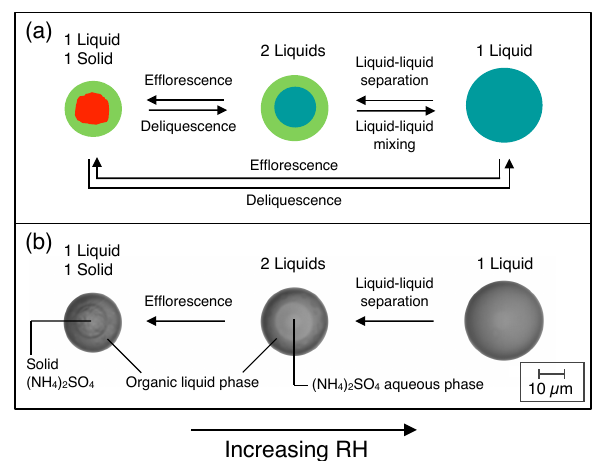
Fig. 1. (a) Some possible phase transitions of mixed organic- ammonium sulfate particles. These transitions can occur as atmo- spheric relative humidity fluctuates between high and low values. Aqua, green, and red respectively represent an aqueous phase, a liq- uid phase of organic material, and a solid phase of crystalline am- monium sulfate ((NH 4 ) 2 SO 4 ). (b) Optical microscope images of a single particle consisting of 1,2,6-trihydroxyhexane and ammonium sulfate (org:sulf = 2.1) showing the sequence from right-to-left of an internally mixed liquid phase, two phase-separated liquids, and a core-shell arrangement of a solid-liquid particle. Images were recorded using 500 × magnification as the relative humidity was de- creased while the temperature was held constant at 291 ±